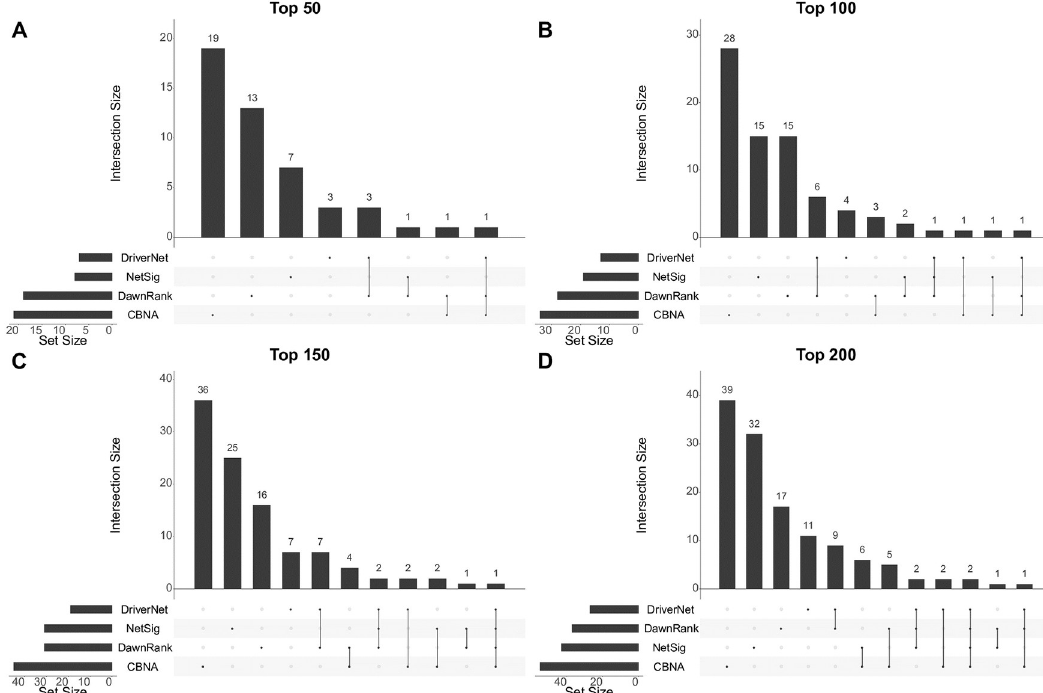
Fig 9. Overlap between different methods. The diagram shows the overlap among the four methods in their top 50, 100, 150, and 200 predicted drivers. For each of the four cases, the horizontal bars at the bottom left show the numbers of predicted cancer drivers validated by the CGC for the four methods; the vertical bars and the dotted lines together indicate the numbers of validated cancer drivers which overlap with each other.